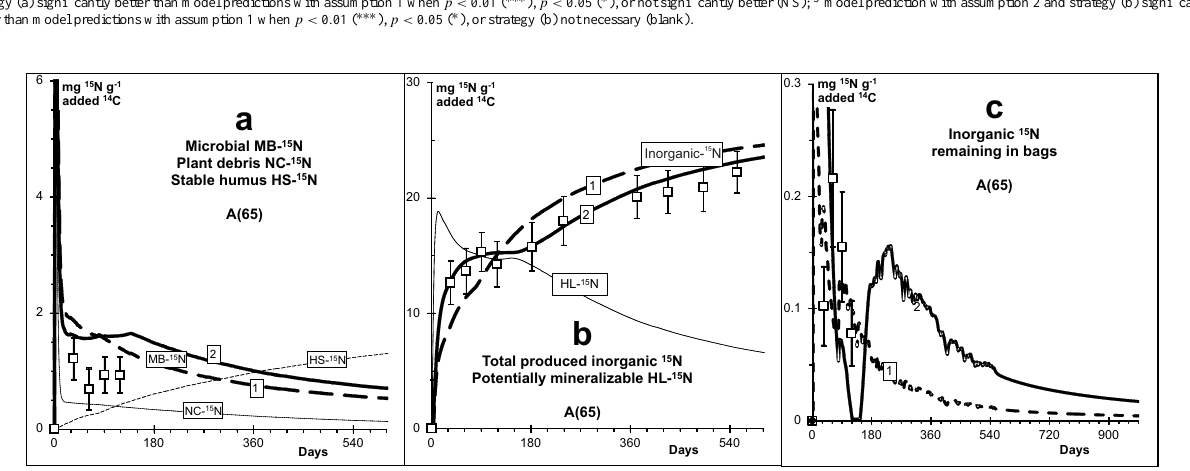
Fig. 3. Measured and simulated values at the lowest site (A65): squares are measured data with 95% confidence intervals of (a) MB- 15 N, (b) total inorganic- 15 N, (c) inorganic 15 N remaining in bags; heavy dashed lines (1) are the simulated values using assumption 1 of constant C:N ratio of MB; heavy solid lines (2) are the simulated values using assumption 2 (variable C:N ratio of MB) and the first strategy (a); the light dotted line in (a) is the simulated 15 N in stable humus HS, the light dashed line in (a) is the 15 N remaining in the plant necromass (NC) and the light solid line in (b) is the potentially mineralizable 15 N in the labile humus